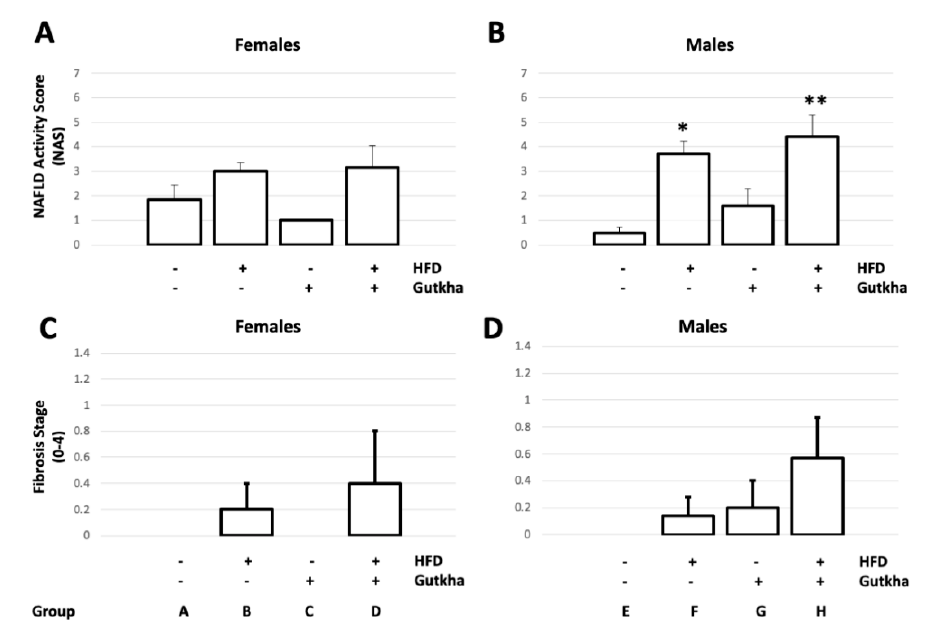
Figure 4. Pathologic Review of Liver Sections. ( A & B ) NAFLD activity scores (NAS) were significantly (* , ** p < 0.05) higher in mice fed a HF diet (HFD). In male mice ( B ) gutkha exposure in utero further enhanced NAS. ( C & D ) Fibrosis stage was generally higher in response to a HFD, significantly so in male mice exposed in utero to gutkha and later fed a HFD. (Stage 1 represents low level fibrosis, Stage 0 = no fibrosis).